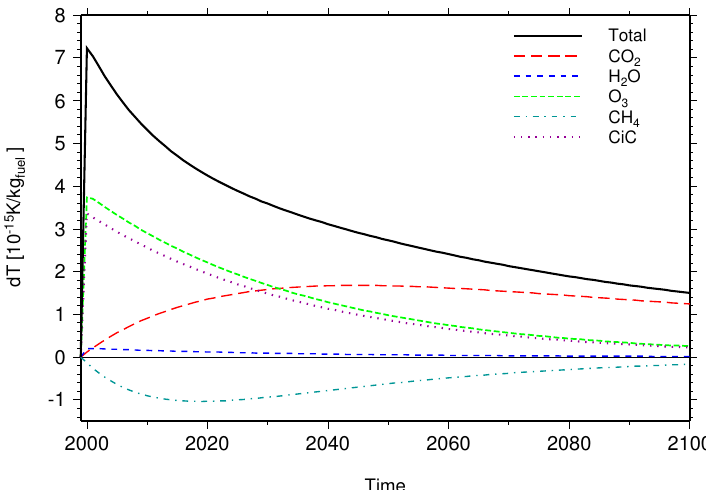
Figure 1. Global average temperature change dT ( t ) per kg fuel calculated for a one-year pulse emission in 2000 based on the REACT4C (Reducing Emissions from Aviation by Changing Trajectories for the benefit of Climate) emission inventory with the climate response model